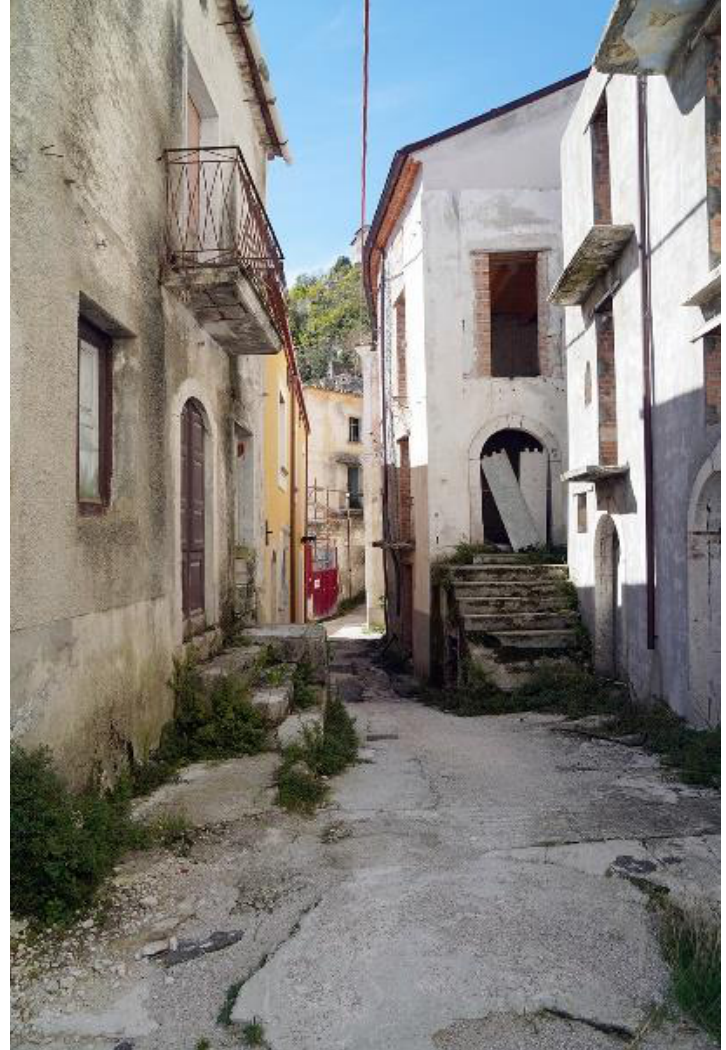
Figure 96. Senerchia: a small street of the old village (photos by [35,36]).